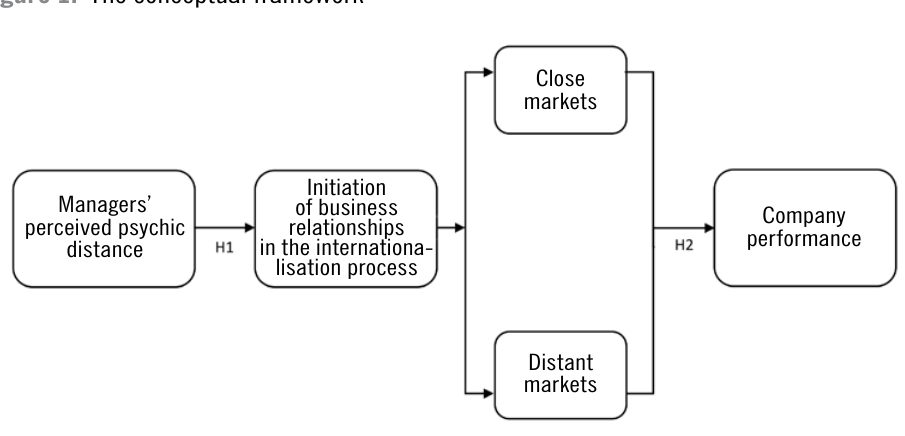
Figure 1. The conceptual framework